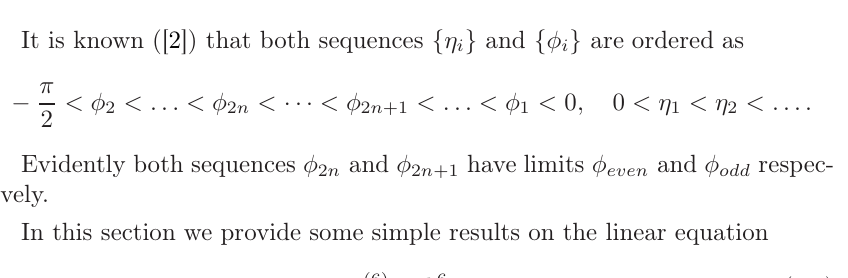
Figure 2. The second extremal function x 2 ( t ) of (2.1) which relates to η 2 , k = 1